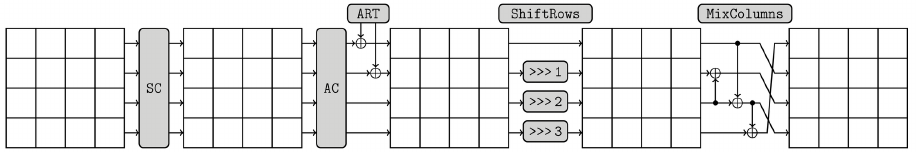
Figure 2: Round function of SKINNY [BJK + 16]